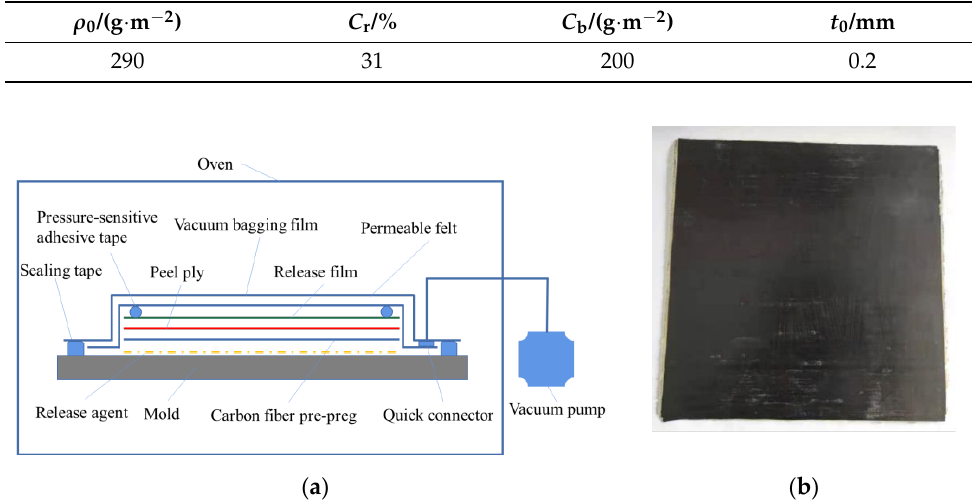
Table 1. Parameters of unidirectional carbon fiber/epoxy pre-preg.